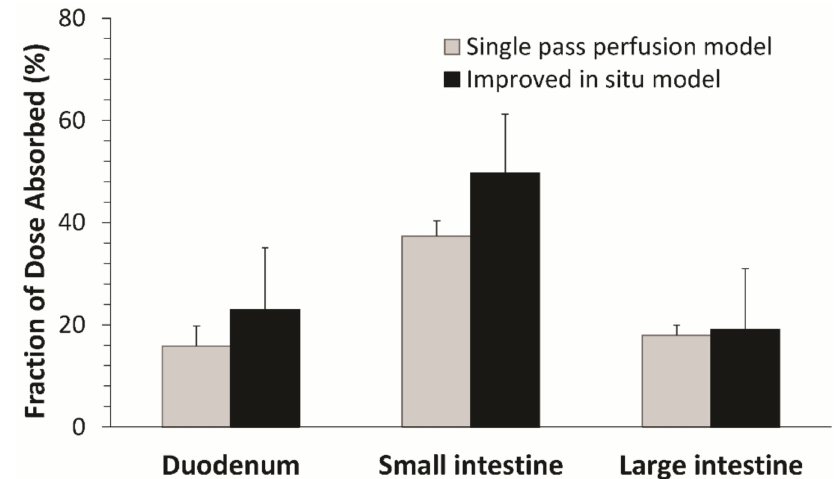
Figure 5. Comparison between the relative fraction absorbed ( F abs,relative ) by the improved in situ absorption model and the fraction absorbed ( F abs ) determined by the single-pass perfusion ( n = 4–6, mean ±